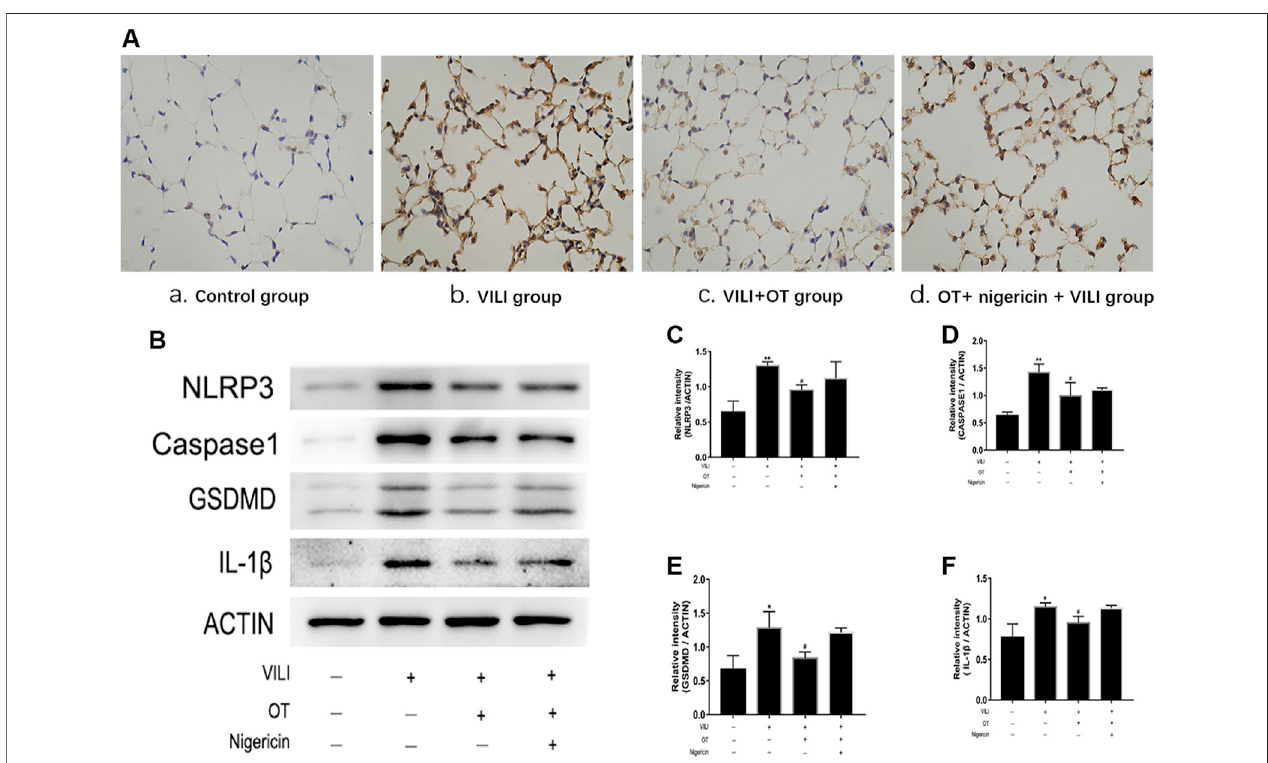
FIGURE 8 | Effects of oxytocin on the expression of NLRP3, Caspase-1, GSDMD, and IL-1 β in lung tissues from VILI mice treated with and without Nigericin. (A) Immunohistochemistry(IHC)stainingofNLRP3ofdifferentgroups:1)Controlgroup,2)VILIgroup,3)VILI+OTgroup,4)OT+nigericin+VILIgroup,and (B) Westernblot analysis of NLRP3, Caspase-1, GSDMD and IL-1 β levels were quanti fi ed. The levels of NLRP3 (C) , Caspase-1 (D) , GSDMD (E) , and IL-1 β (F) protein expression were quanti fi edbymeasuringbandintensitiesanddisplayedasfoldincreaserelativetoACTIN.Thevaluespresentedarethemeans ± SD( n (cid:2) 5).* p < 0.05and** p < 0.01